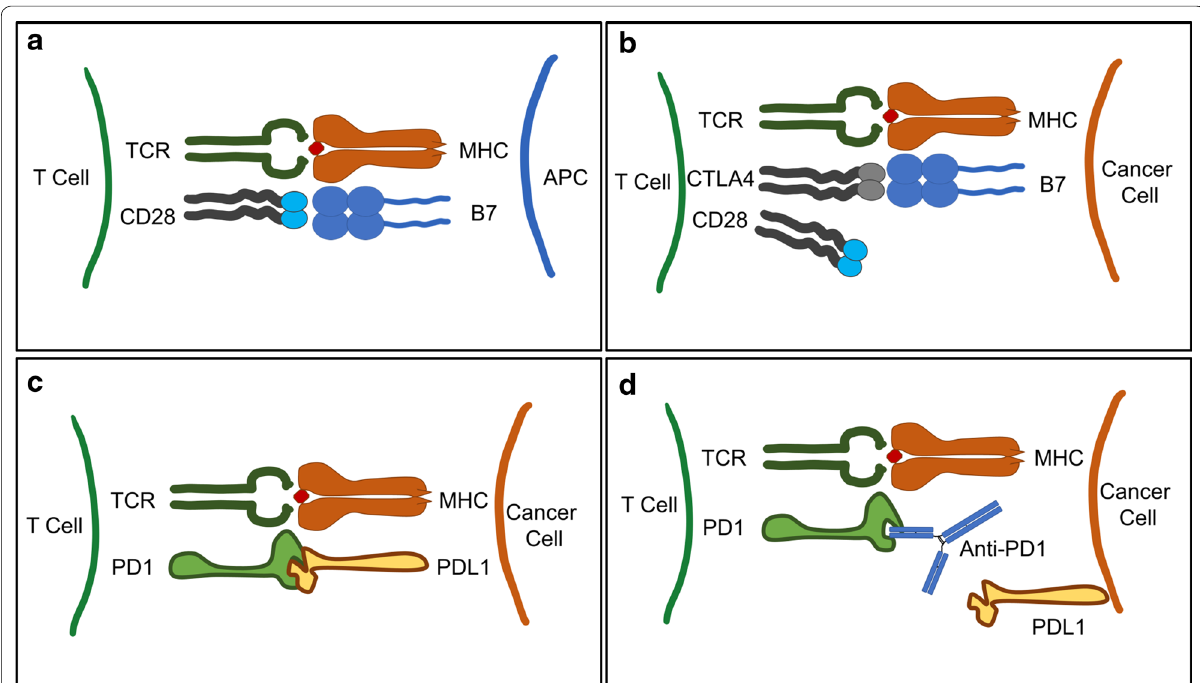
Fig. 1 Schematic of T cell interactions. a Major histocompatibility complex (MHC) on antigen presenting cell (APC) binding to T cell receptor (TCR) along with the costimulatory B7-CD28 interaction. b CTLA-4 competitively inhibits the binding of B7 to CD28 and results in dampened T cell activation and proliferation. c PD-1 on a T cell binding to PD-L1 expressed on a cancer cell to decrease T cell activation. d Anti-PD-1 antibody binding to PD-1 and eliminating the negative effect of the PD-1/PD-L1 axis on T cell function